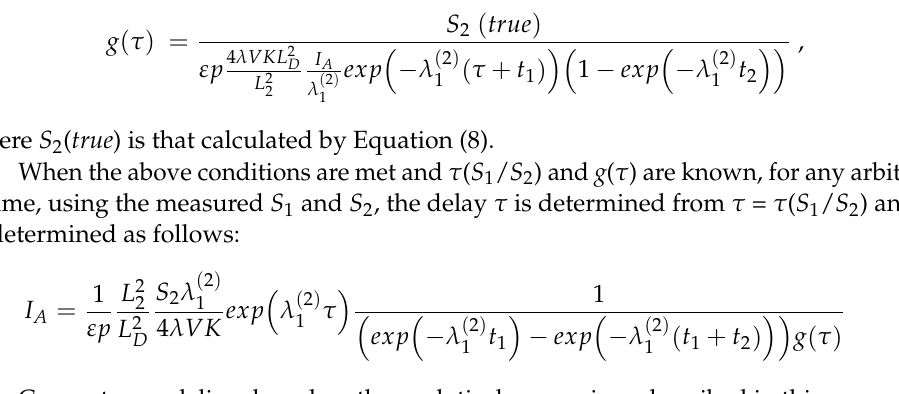
Figure 4. An arbitrary example of a plume. As the “end of plume” may be not well-defined, it is preferred to use the delay from the center of the plume. The moment of this center is = (for rectangular plumes, it is T